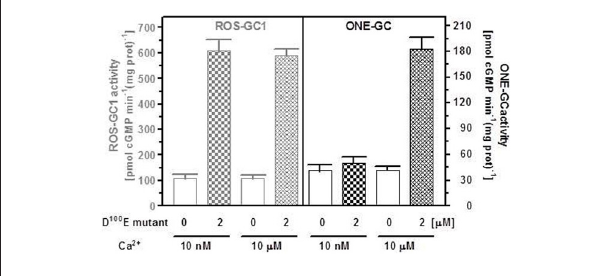
FIGURE 7 | The D 100 E GCAP1 mutant stimulates both ONE-GC and ROS-GC1 at high Ca 2 + concentration but only ROS-GC1 in the absence of Ca 2 + . The membrane fraction of COS cells expressing ONE-GC or ROS-GC1 (control) were assayed for guanylate cyclase activity in the presence (2 μ M) or absence of D 100 E GCAP1 mutant and 1mM EGTA (10 μ M Ca 2 + ) or 10 μ M Ca 2 + . The experiment was done in triplicate and repeated two times for reproducibility. The results shown are average ± SD from these experiments.